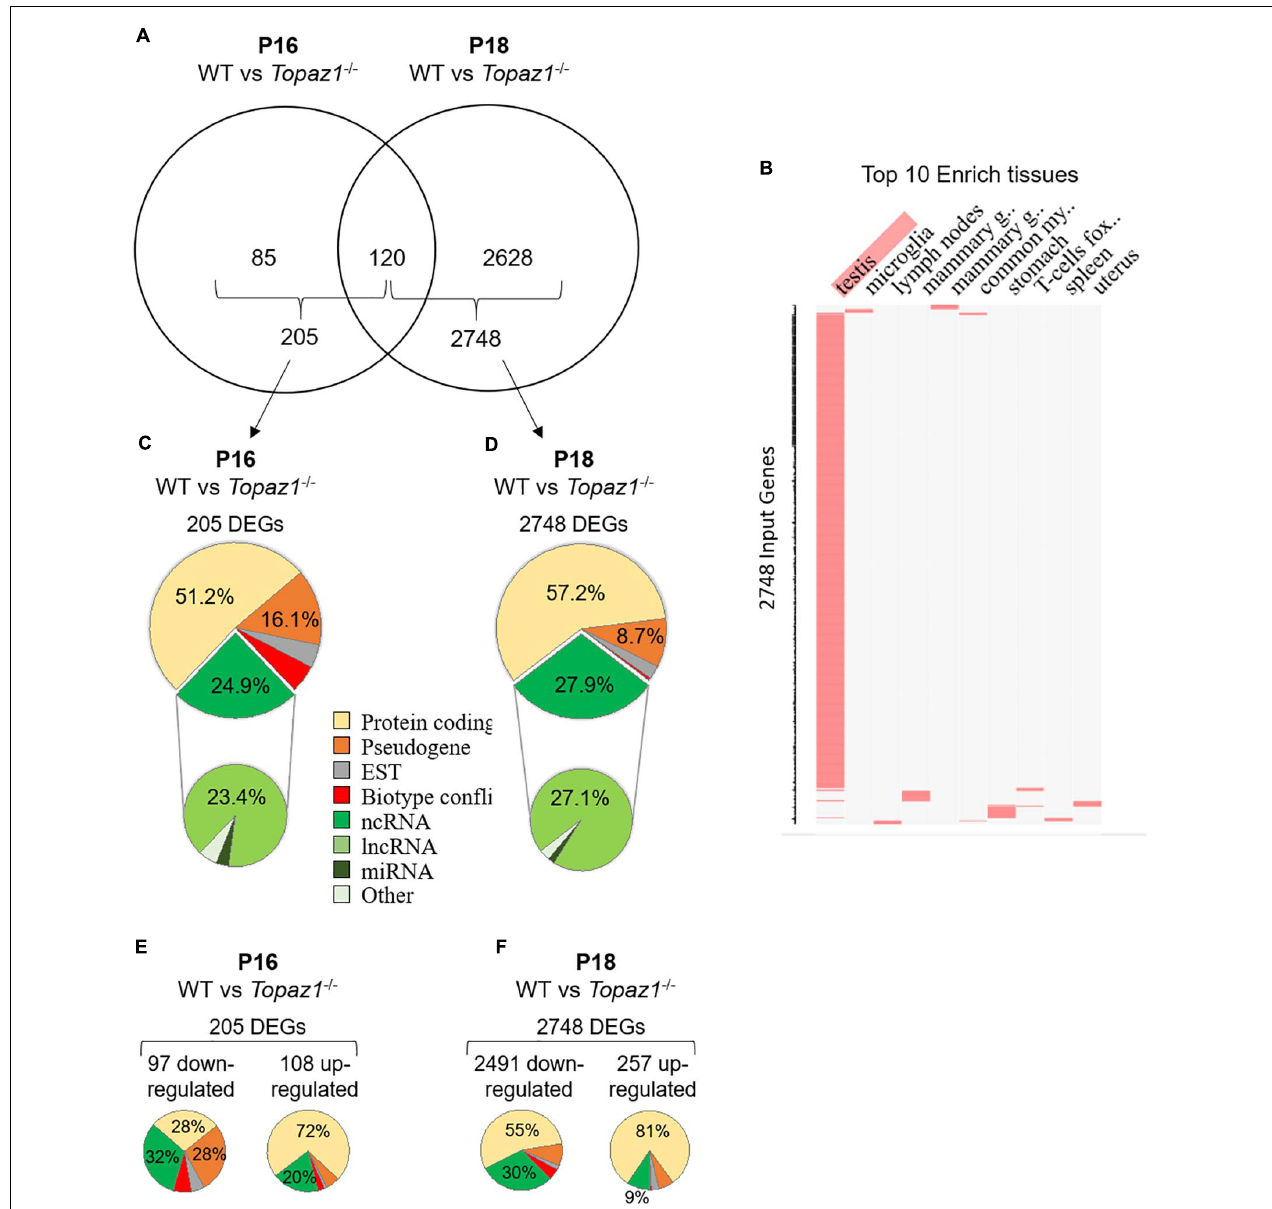
FIGURE 1 | WT vs. Topaz1 − / − deregulated gene analysis from mouse testes. (A) Venn diagram showing the overlap of differentially expressed genes between P16 and P18 Topaz1 − / − mouse testes [adjusted p < 0.05 and down-regulated FC < 0.5 (log2FC < − 1) or up-regulated FC > 2 (log2FC > 1)]. (B) Clustergrammer was generated by the Enrichr website. Top 10 enriched tissues are the columns, input genes (2748 DEGs of P18 Topaz1 − / − compared to normal testes) are the rows, and cells in the matrix indicate whether a DEG is associated with a tissue from the Mouse Gene Atlas. (C,D) Biotype of DEGs in Topaz1 − / − testes at (C) P16 and (D) P18. Around half of them are protein-coding genes whereas around one quarter is ncRNA at both developmental stages. (E,F) Biotype of DEGs in Topaz1 − / − testes at (E) P16 and (F) P18, depending on whether they were up- or